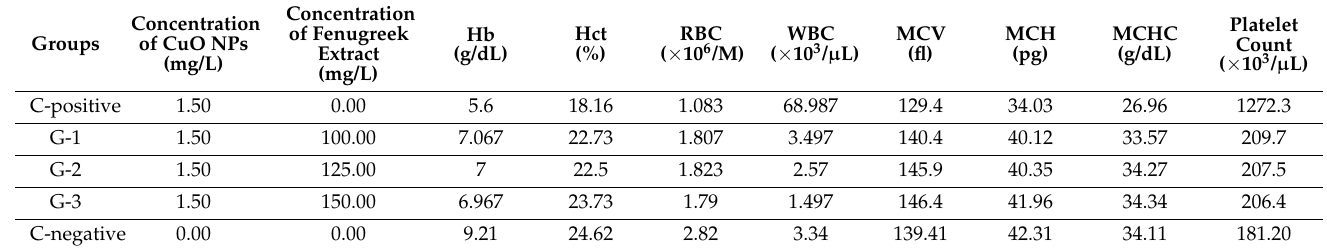
Table 3. Values of different hematological parameters of the common carp ( C. carpio ) experimentally exposed to CuO NPs and different concentrations of the fenugreek ( T. foenum-graecum ) extract for 28 days. Data are expressed as means (SE; n =